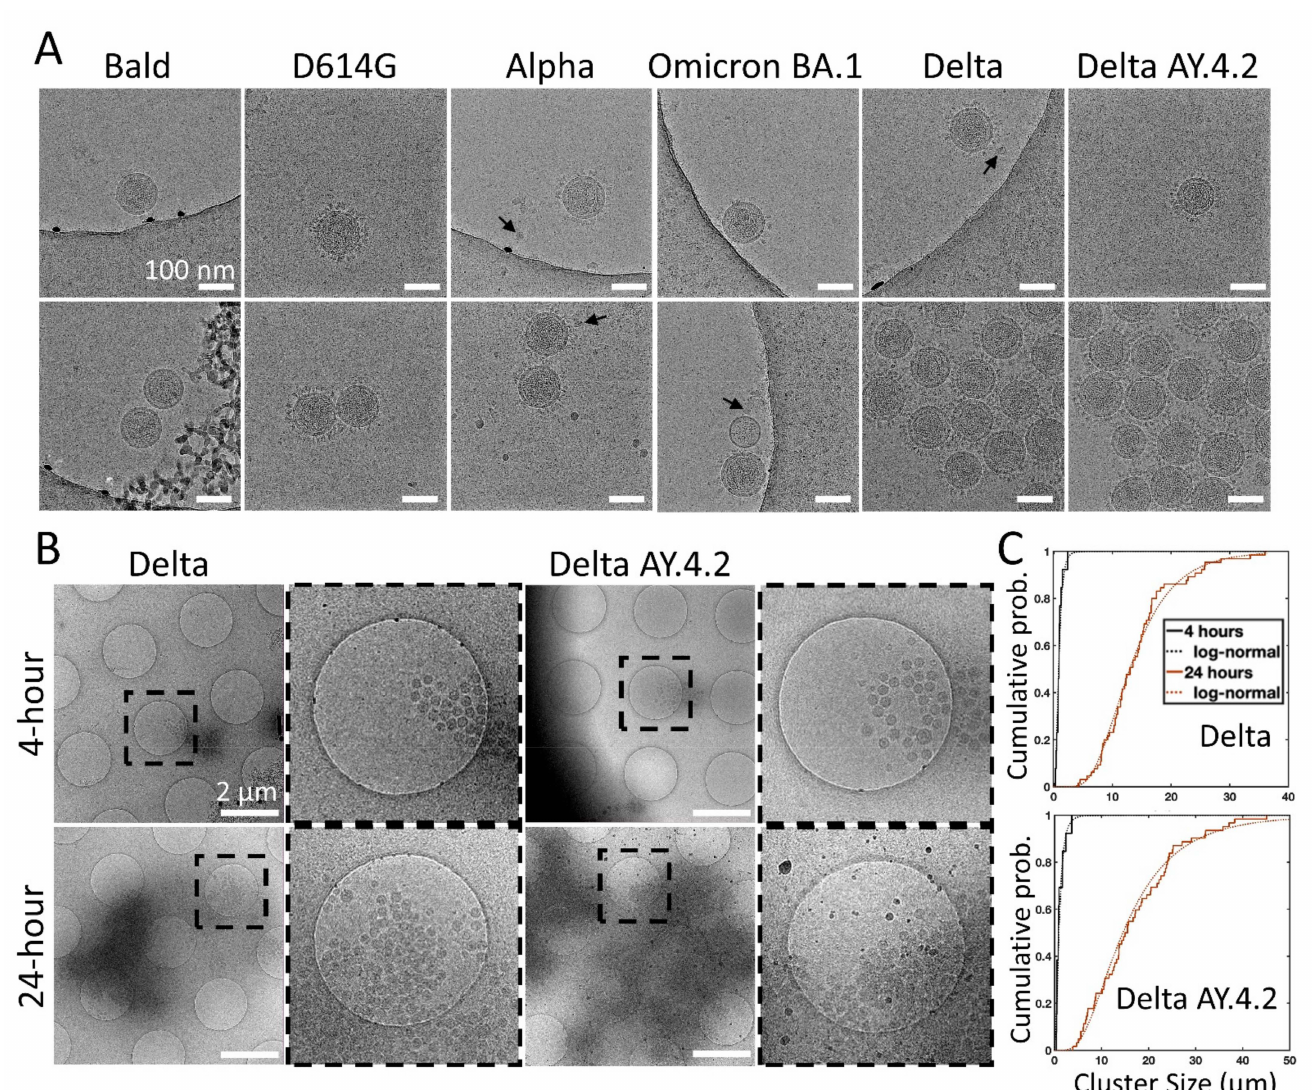
Figure 5. Cryo-electron microscopy of spike variant PVs. ( A ) Examples of singles (top panel), doubles, or aggregates (lower panel) of each variant PV. Spike variant is identified above. Black arrows indicate lipoprotein-like particles. The average PV envelope diameters for each variant are 118.6 (1.1), 118.5 (1.2), 119.6 (0.9), 120.1 (1.3), 115.8 (0.8), and 118.4 (0.6) nm for Bald, D614G, Alpha, Omicron